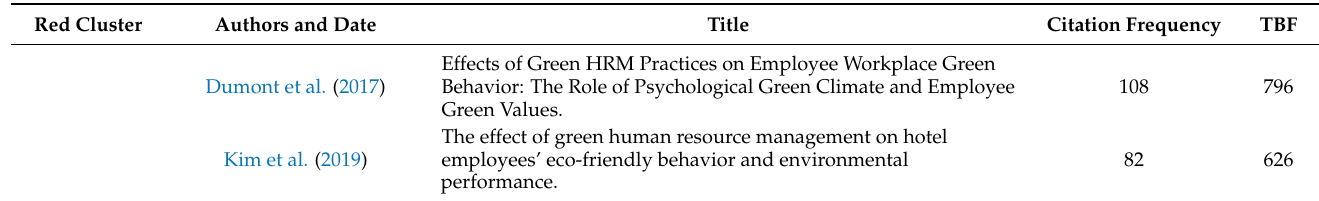
Table A4. Publications from the bibliographic coupling analysis—red